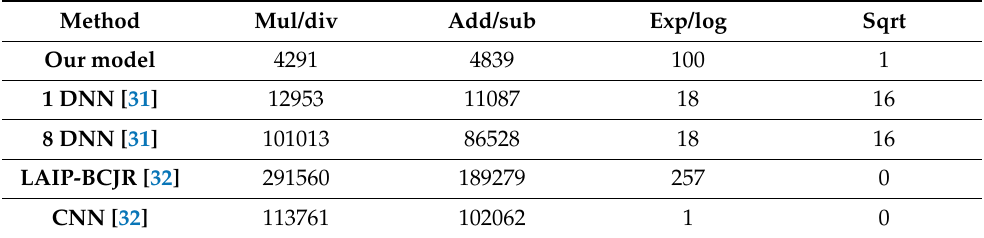
Table 7. The complexity for our proposed and other